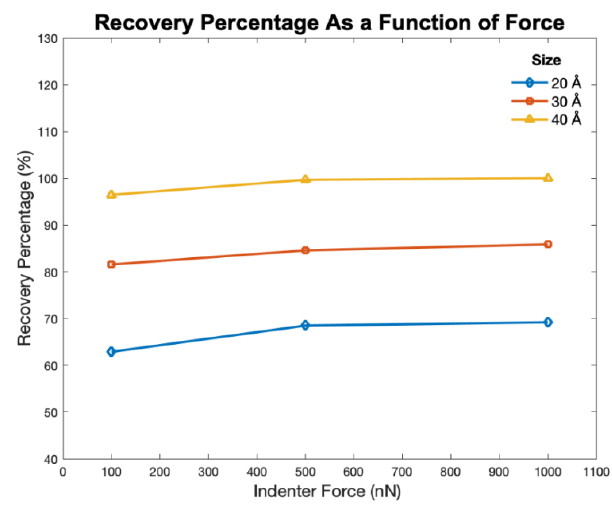
Figure 8. Recovery percentage as a function of size and force.